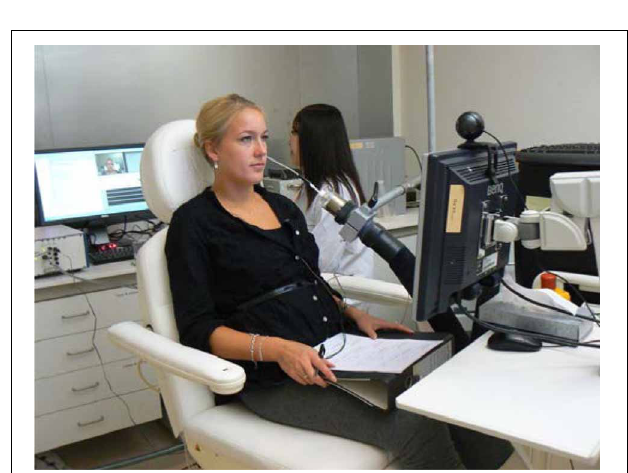
Photograph 1 | Set-up used in this study showing the participant and the experimenter, the arm of the olfactometer for odor presentation, and the monitor used for instructions with a camera used for facial